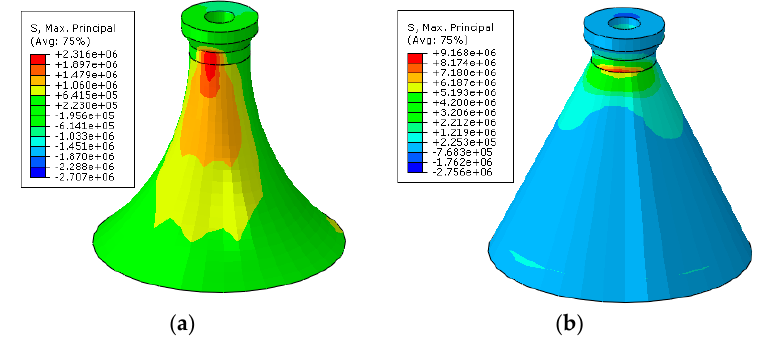
Figure 7. Stress transfer of the pre-stressed part: ( a ) Arc type; ( b ) Line type.